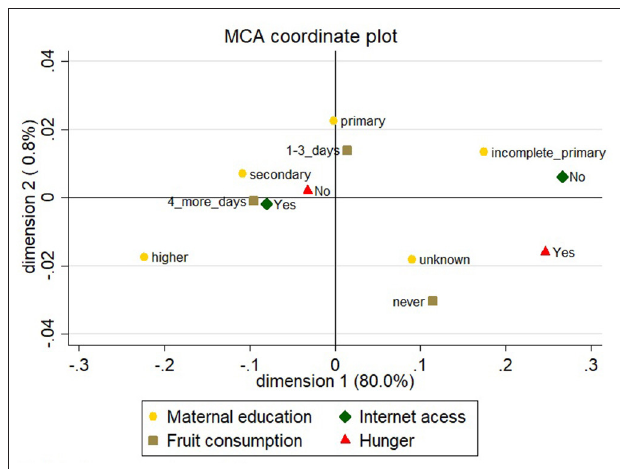
FIGURE 2 | Multiple Correspondence